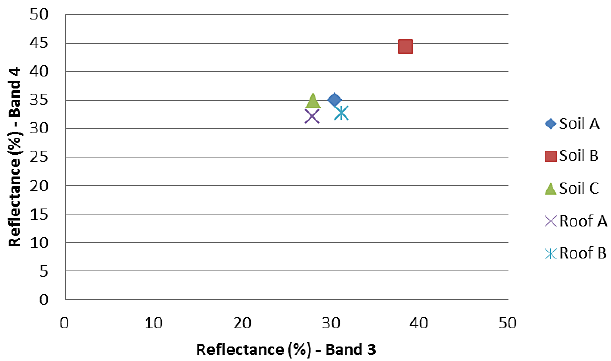
Fig. 2. Flow chart of the proposed methodology.